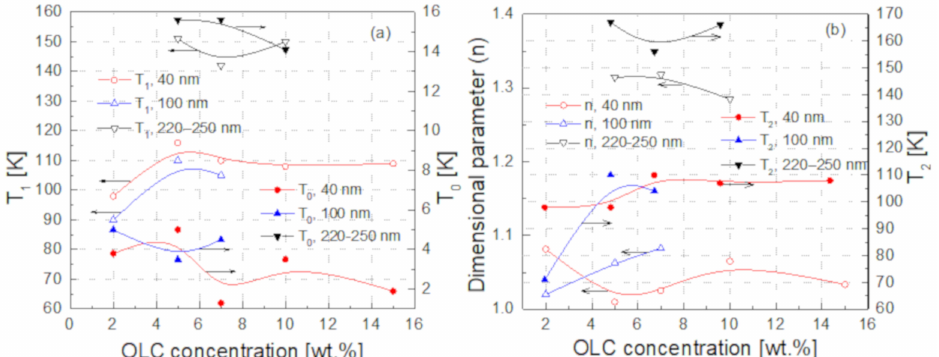
Figure 6. Parameters for fitting the experimental data in Figure 3, as a function of filler concentration for different sizes of OLC: T 0 and T 1 from the fit by Equation (3) ( a ), and dimensional parameter n and parameter T 2 from the fit by Equation (4) ( b